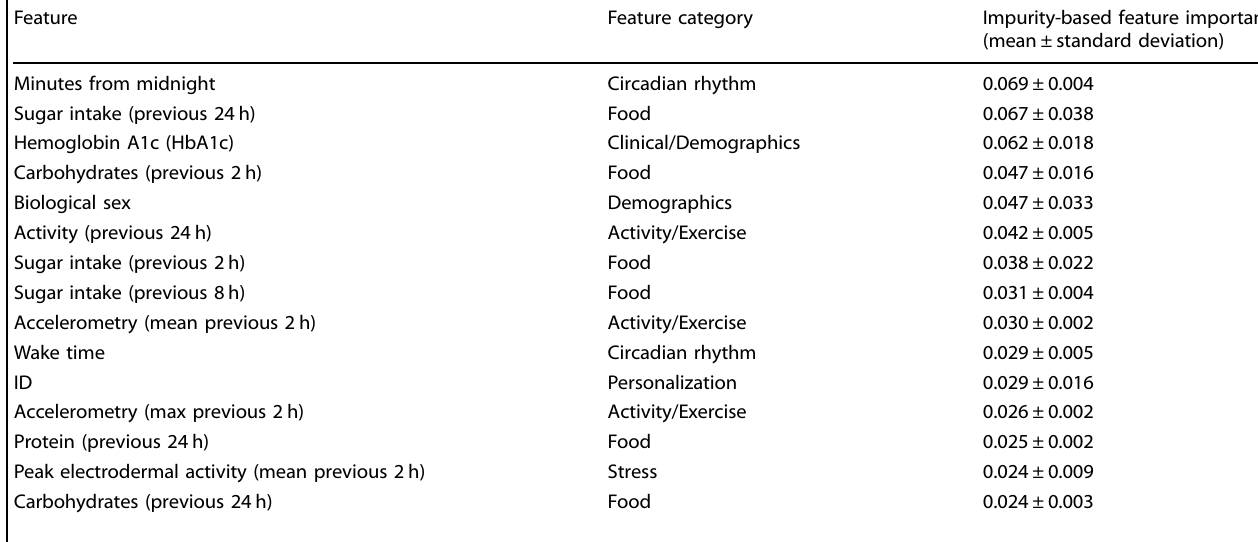
Table 3. Exploring feature importance for glucose prediction: the 15 most important features in the random forest